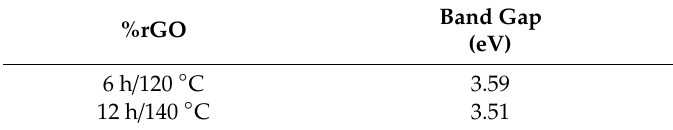
Table 3. Band gap energy of 5%rGO / Bi as a function of treatment time and temperature.